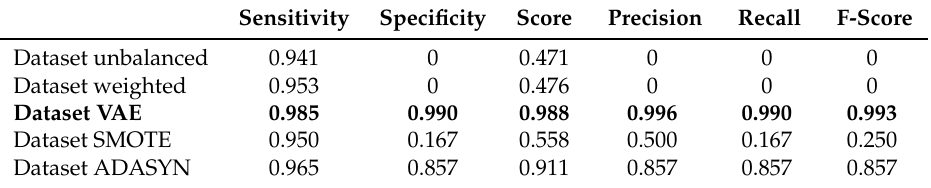
Table 5. Metric results obtained with the five classifications over chronic